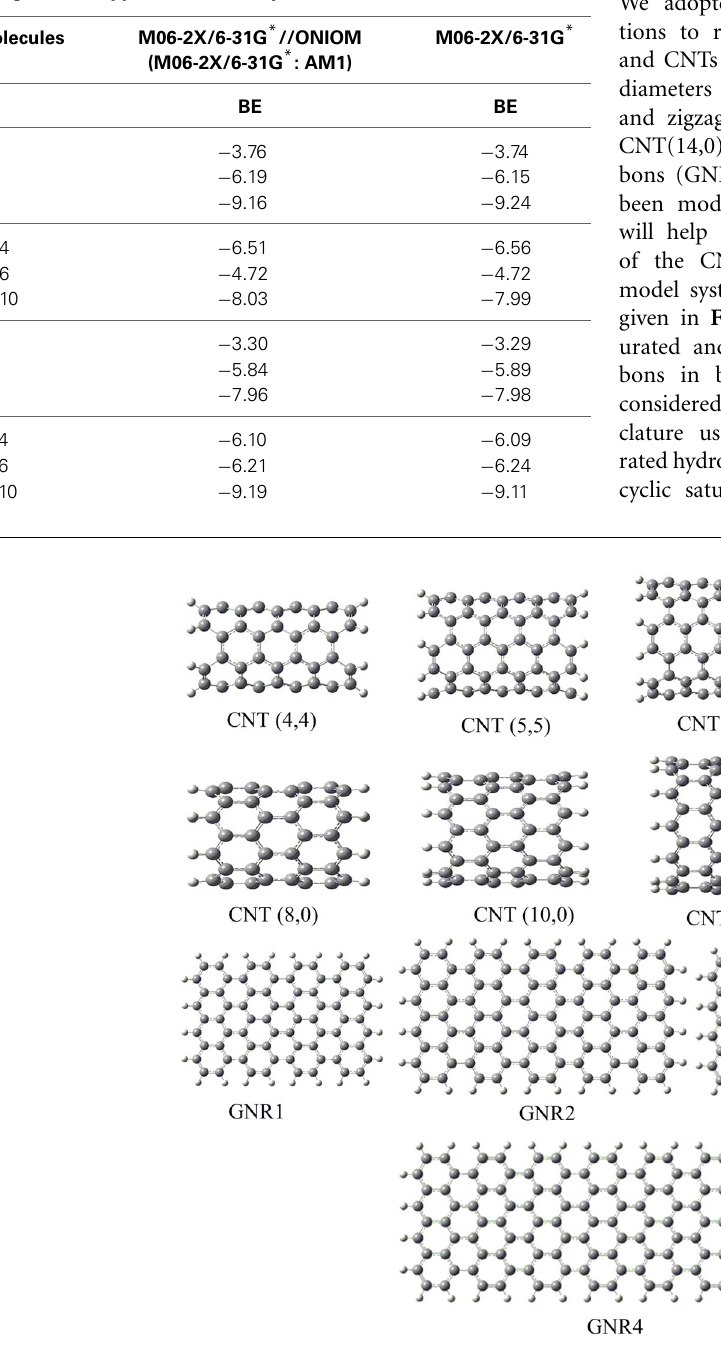
Table 1 | BE (kcal/mol) of the hydrocarbons with CNT (4,4) obtained using ONIOM approach and full optimization.